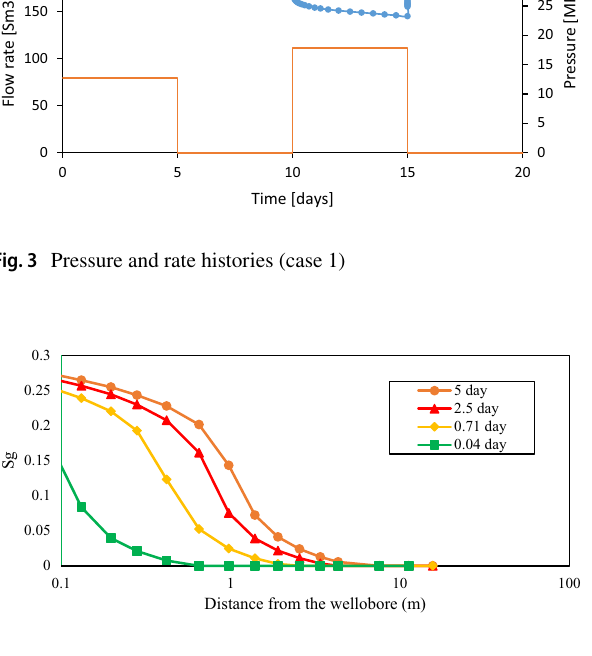
Fig. 4 Gas saturation profile around the wellbore in DD1 test at dif- ferent times from start of production (case 1)